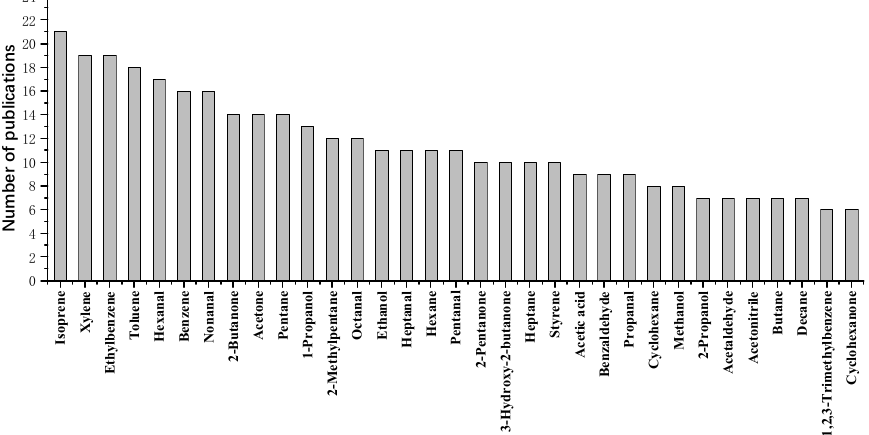
Figure 3. VOCs are most often noted as lung cancer biomarkers in exhaled breath.